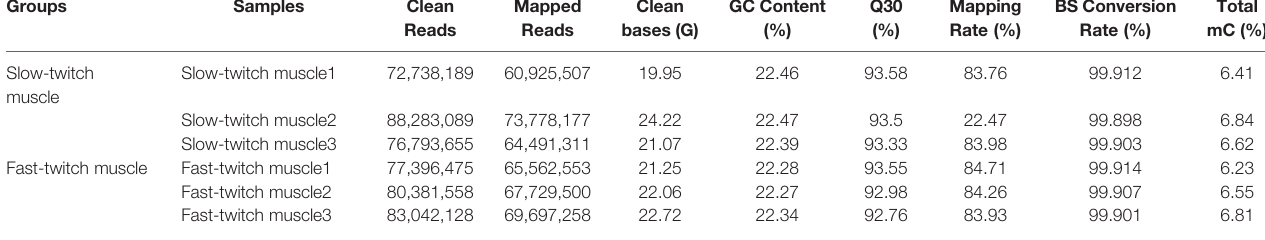
TABLE 1 | Summary of whole-genome bisul fi te sequencing (WGBS) sequencing data in P. dentex skeletal muscles. Groups Samples